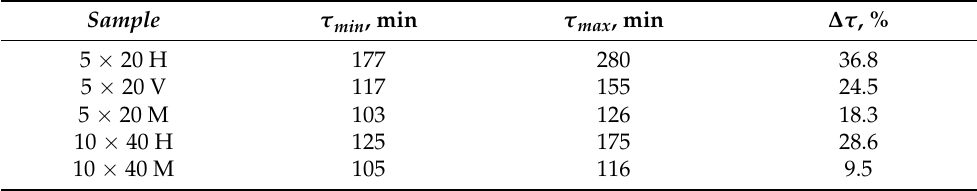
Table 3. Heating times of individual samples in a furnace with the temperature of 800 ◦